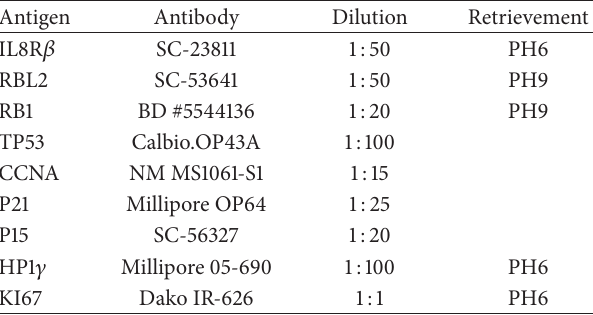
Table 3: Senescence markers in irradiated fibroblasts.